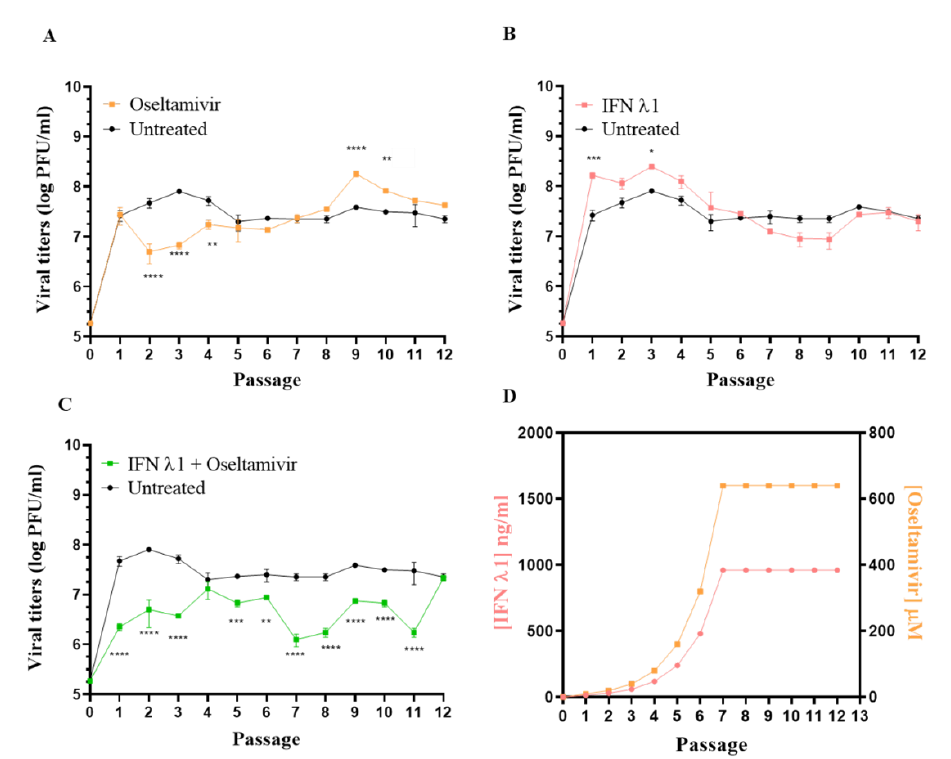
Figure 3. Comparison of viral titers from viral supernatants collected from Calu-3 cells infected with A(H1N1)pdm09 for 48 h in the presence of increasing concentrations of OS ( A ), IFN λ1 ( B ), and OS plus IFN λ1 ( C ), this over 12 consecutive passages in Calu-3 cells. Each population is shown together with the untreated control, serially passaged in the absence of selective drug pressure. The titer (performed in MDCK cells) is expressed in plaque-forming units per milliliter (log PFU/mL). The drug concentration at each passage is also shown ( D ). The results represent the mean and standard deviation from two independent titrations. *, p ≤ 0.05; **, p ≤ 0.01; ***, p ≤ 0.001; ****, p ≤ 0.0001.